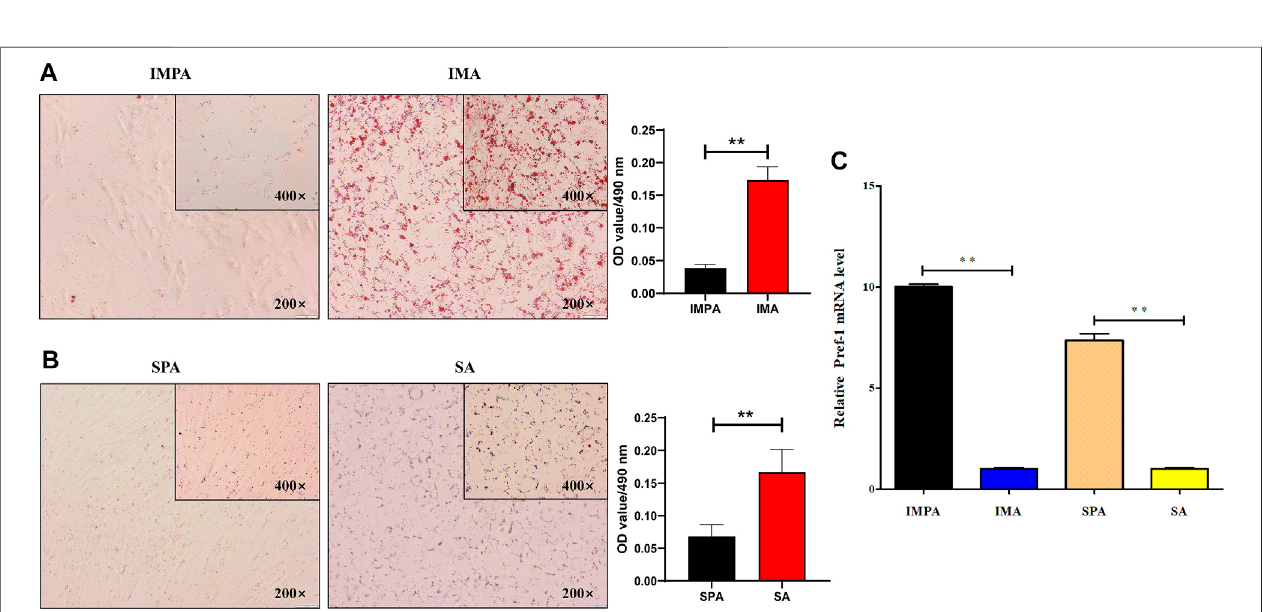
FIGURE1| Adipocytesdifferentiatedfor3 days (A) Oil-redOstaininganalysisingoatintramuscularadipocyteadipogenesis. “ * ” means p < 0.05and “ ** ” means p < 0.01, same below. (B) Oil-red O staining analysis in goat subcutaneous adipocyte adipogenesis. (C) The mRNA level of Pref-1 in goat intramuscular and subcutaneous adipocyte